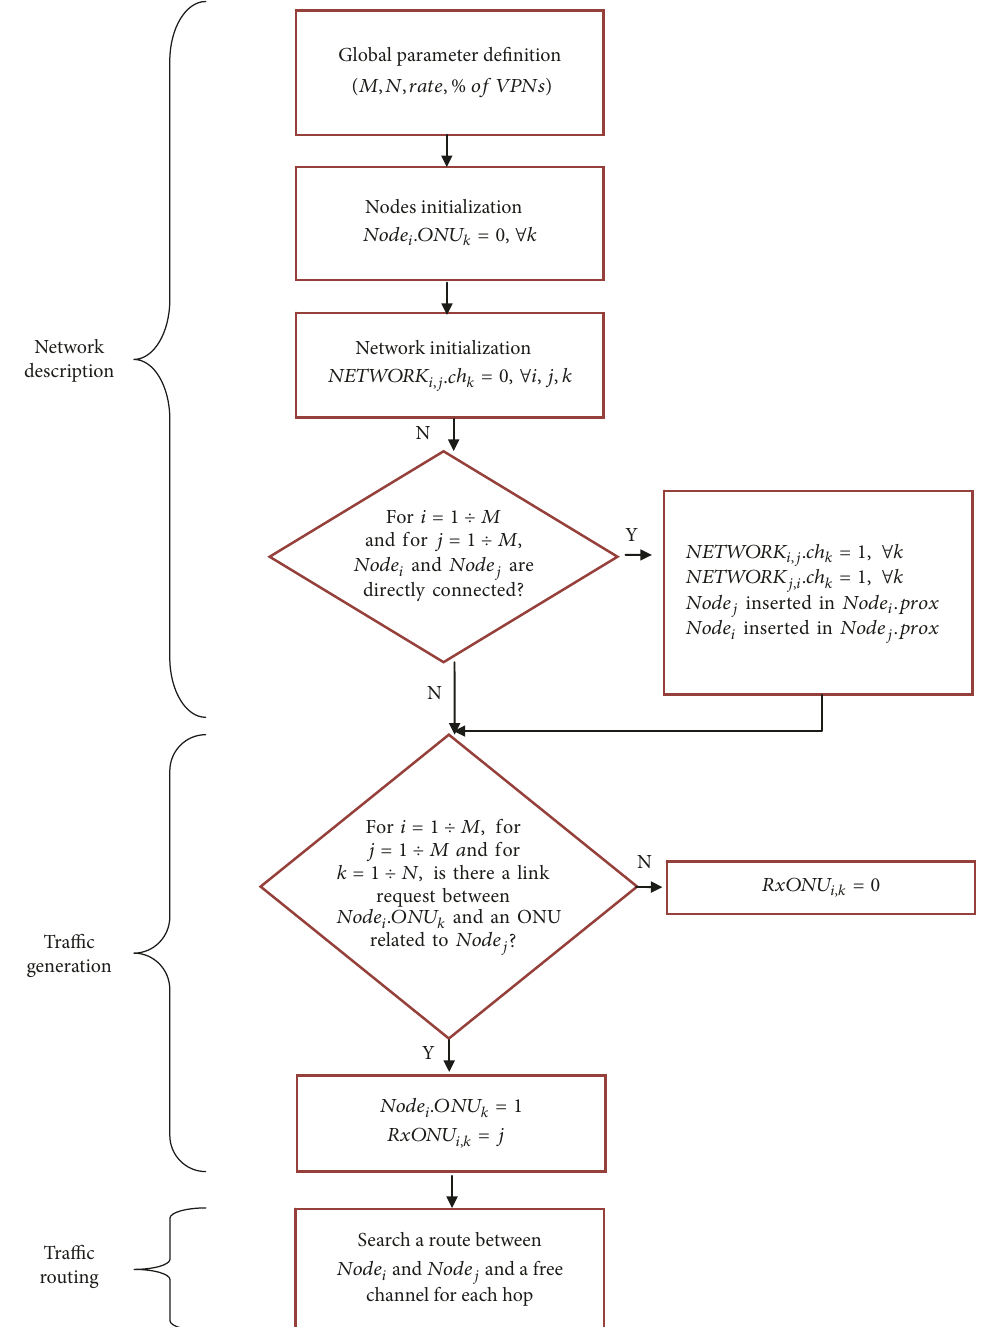
Figure 17: Simplified flow chart of each iteration of the Monte Carlo analysis to simulate network